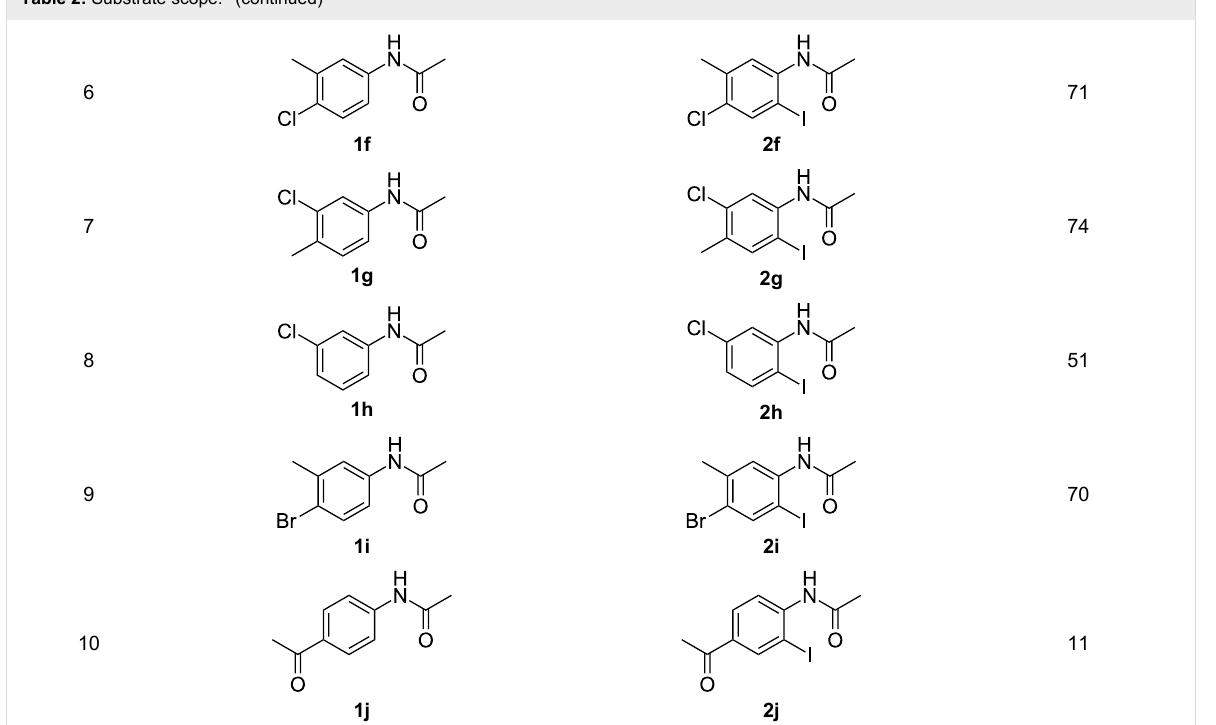
Table 2: Substrate scope. a